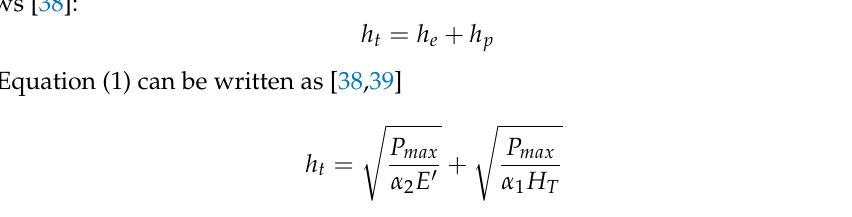
Figure 10. The nanomechanical properties of L-PBF and cast Inconel 718 alloy: Contact hardness ( H c ) and Young’s moduli ( E ).